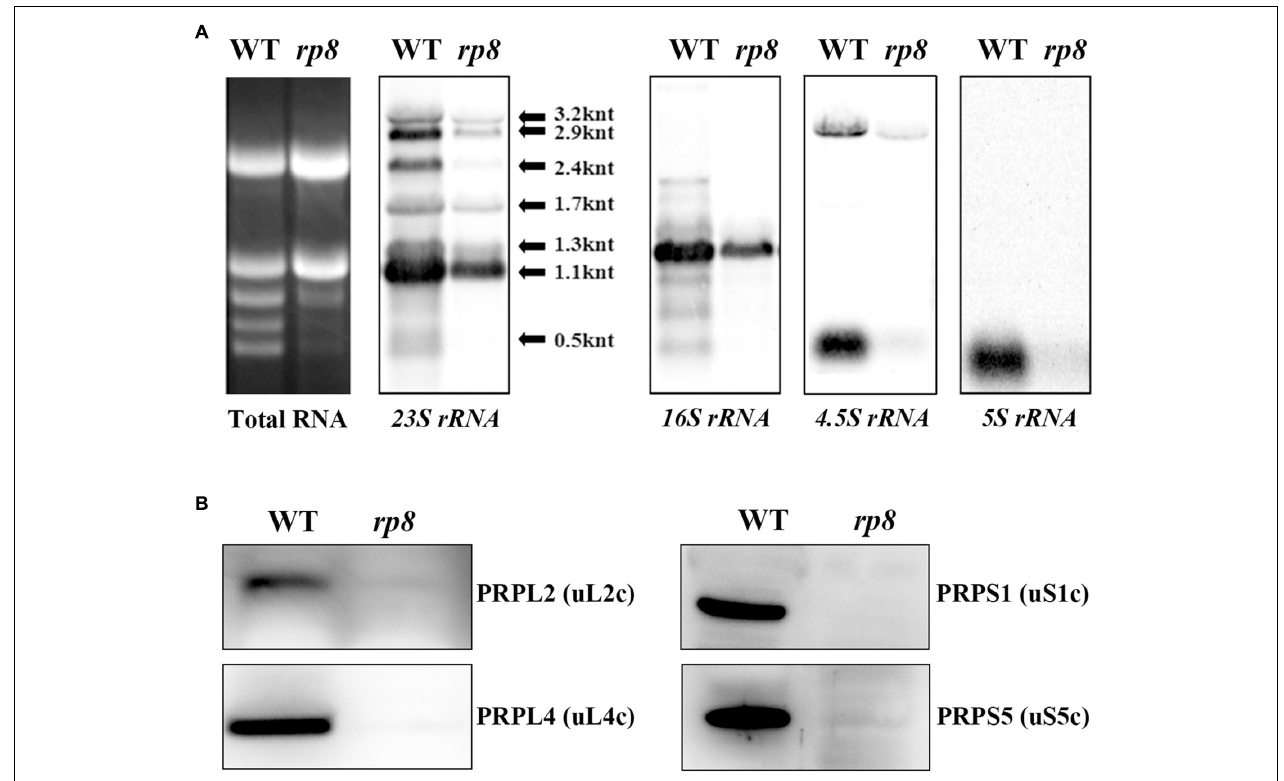
FIGURE 7 | Analysis of chloroplast ribosomes in the wild type (WT) and the rp8 mutant. (A) Total RNA in the WT and the rp8 mutant and Northern blot analysis of chloroplast-encoded rRNAs. (B) Immunoblot analysis of chloroplast ribosomal proteins PRPS1 (uS1c), PRPS5 (uS5c), PRPL2 (uL2c), and PRPL4 (uL4c) in the WT and the rp8 mutant. Each lane was loaded with 30 µ g total